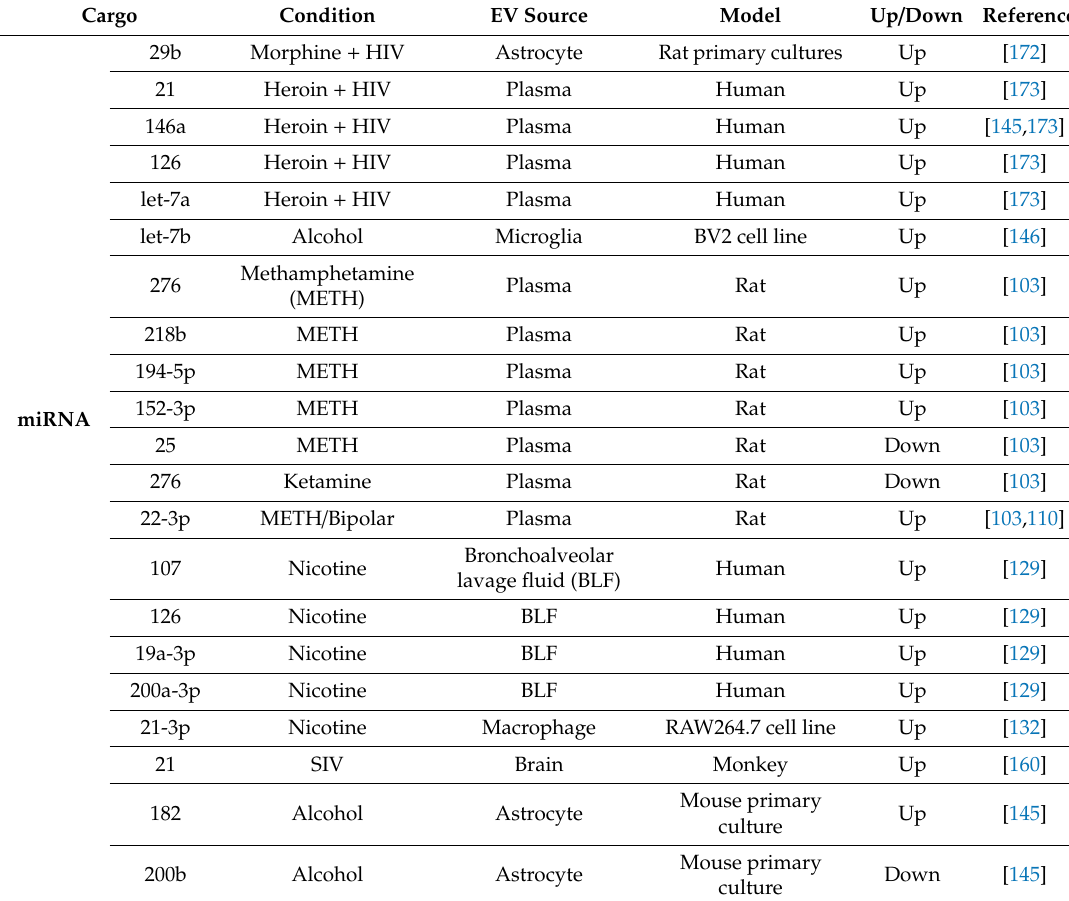
Table 1. Di ff erentially regulated EV cargoes identified in studies of substance abuse and